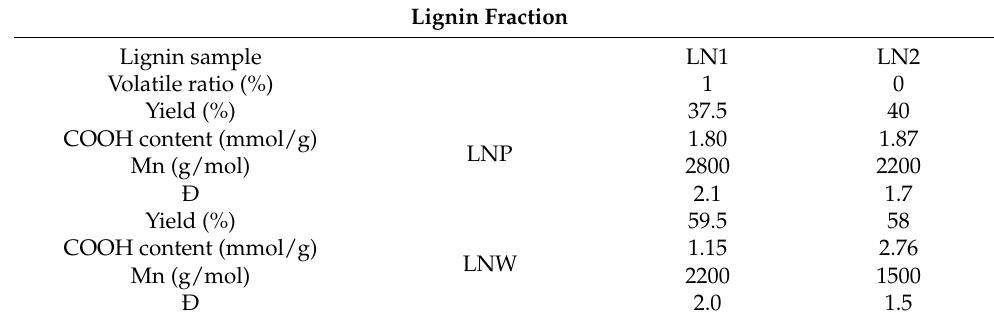
Table 4. Oxidative depolymerization of different lignin sample (10 Bar O 2 , 1 h); precipitated lignin (LNP), hydrosoluble lignin (LNW).